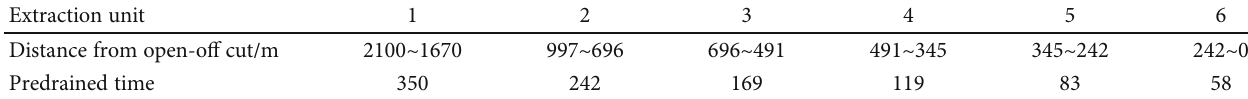
Table 2: Division of extraction units and preextracted time in the working face.